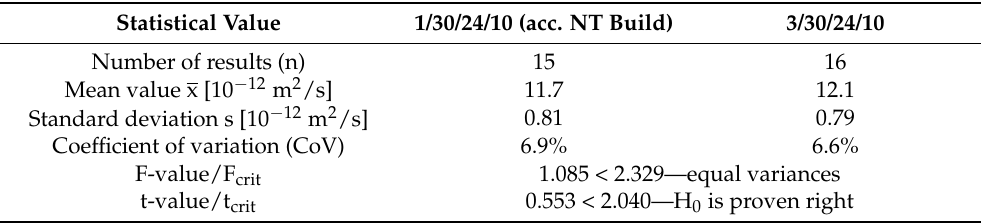
Table 5. Comparison of D nssm determined from specimen preparation according to NT Build (1/30/24/10) and from modified specimen preparation 3/30/24/10